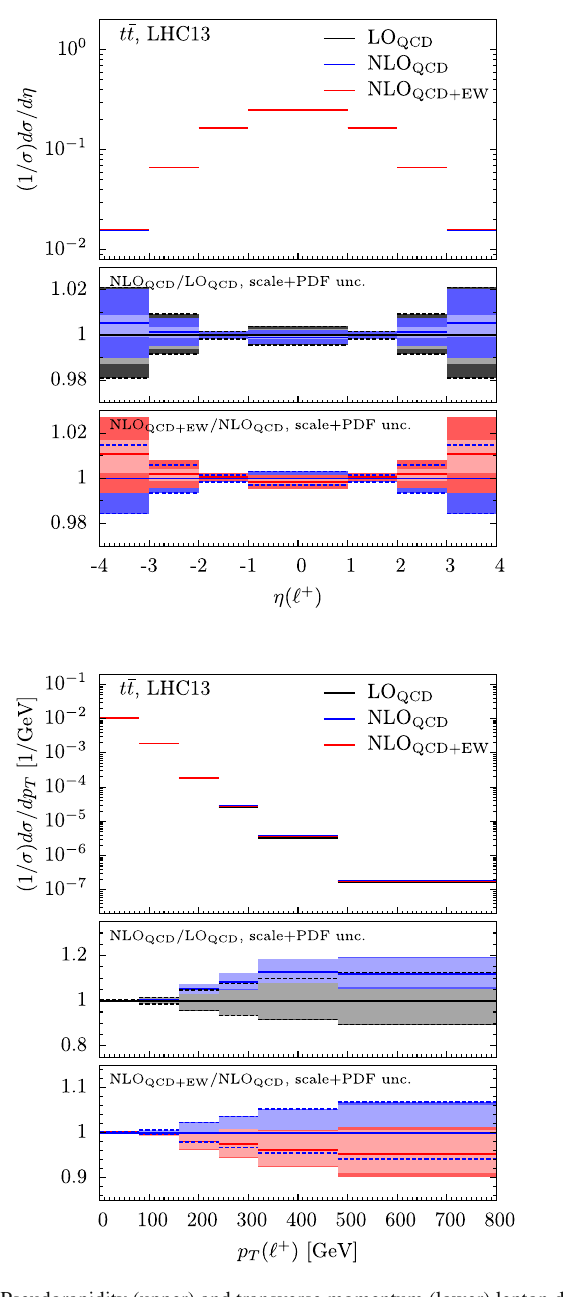
We continue the description of the lepton pair by showing the invariant mass and the transverse mass of the system in Fig. 2 (lower plots). In the p T ((cid:4) + (cid:4) − ) we firstly observe the very large effect of the NLO QCD corrections, a giant K - factor appearing in the highly cross-section suppressed tail, which is already known [15], and secondly that the effect of the EW corrections is negligible for this distribution. Moving to the m ((cid:4) + (cid:4) − ) distribution we see an EW effect of ∼ 2% below 500 GeV and of ∼ 5% after 500 GeV. The m ((cid:4) + (cid:4) − )